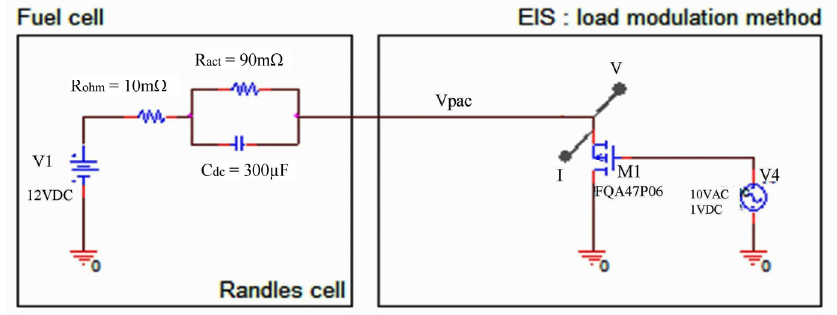
Figure 1. Schematic diagram of the electrical method used for simulation.